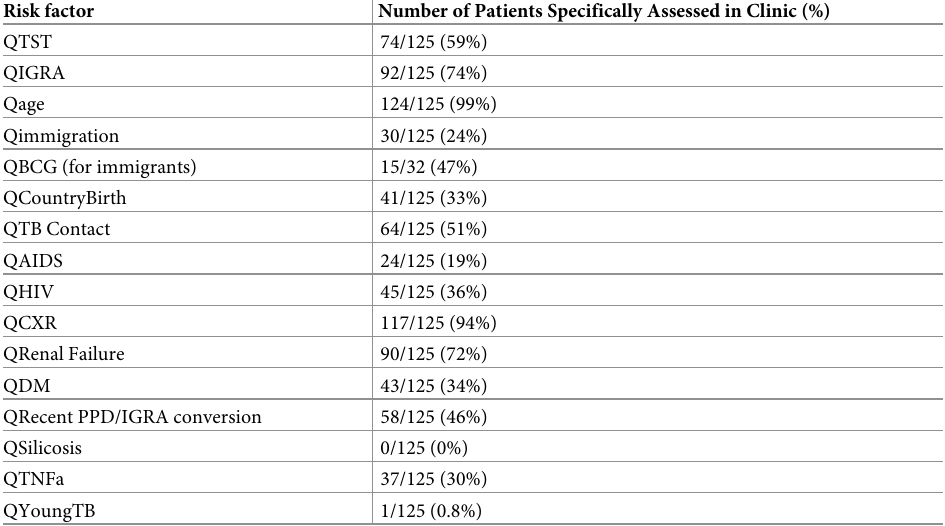
Table 3. Subjects with latent tuberculosis who were assessed for the different risk factors by infectious diseases clinic providers.